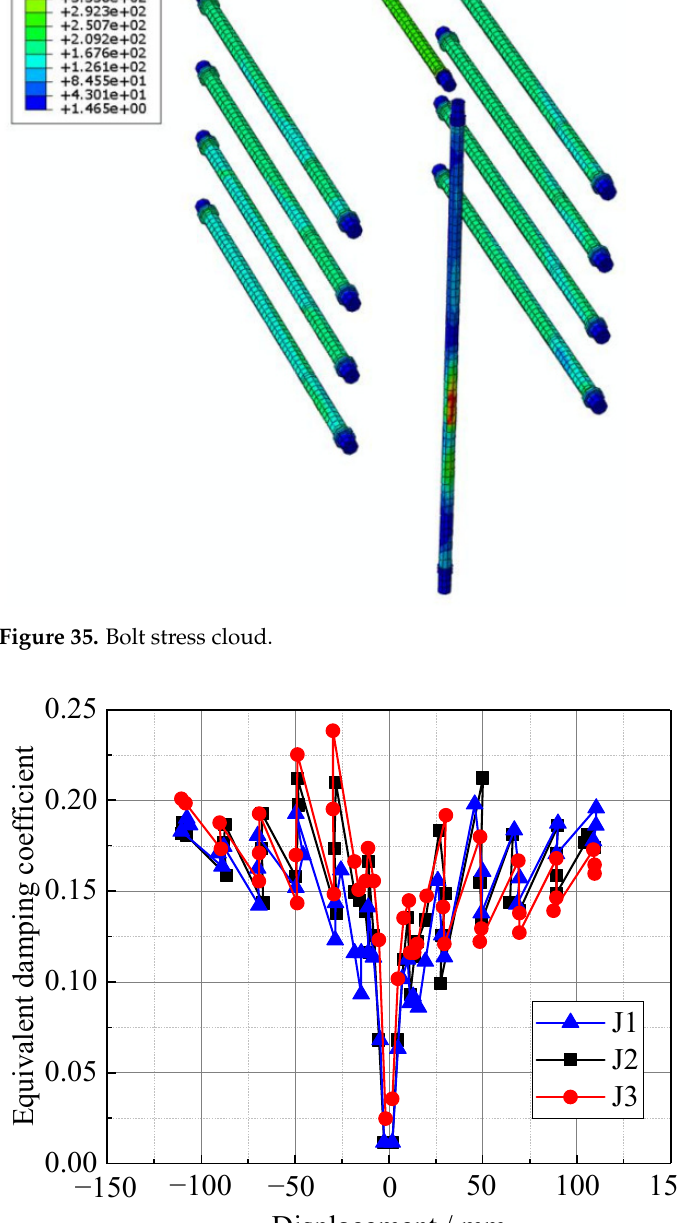
Figure 36. J1, J2, and J3 equivalent viscous damping coefficients.